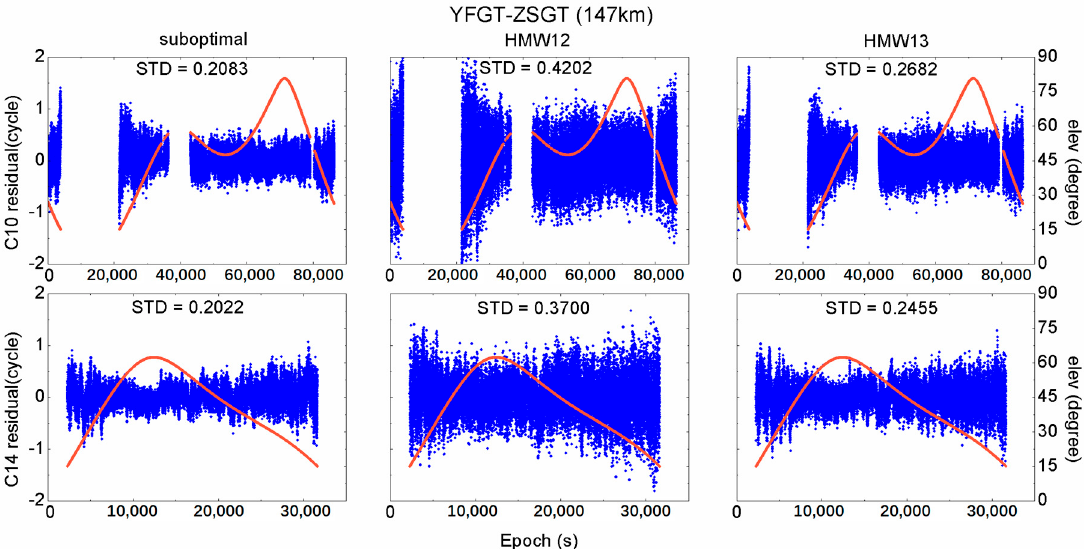
Figure 7. Comparison of ambiguity residuals and the corresponding standard deviations of suboptimal , suboptimal , HMW 12, and HMW 13 combinations for the medium baseline (147 km).